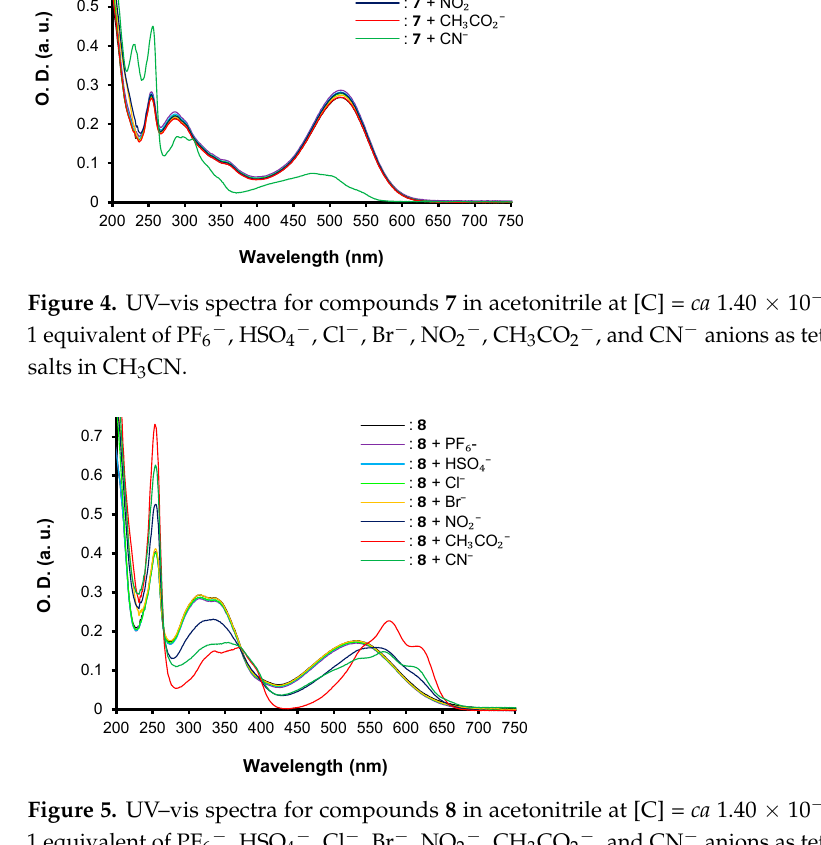
Figure 5. UV–vis spectra for compounds 8 in acetonitrile at [C] = ca 1.40 × 10 − 5 M in presence of 1 equivalent of PF 6 − , HSO 4 − , Cl − , Br − , NO 2 − , CH 3 CO 2 − , and CN − anions as tetrabutylammonium salts in CH 3 CN.